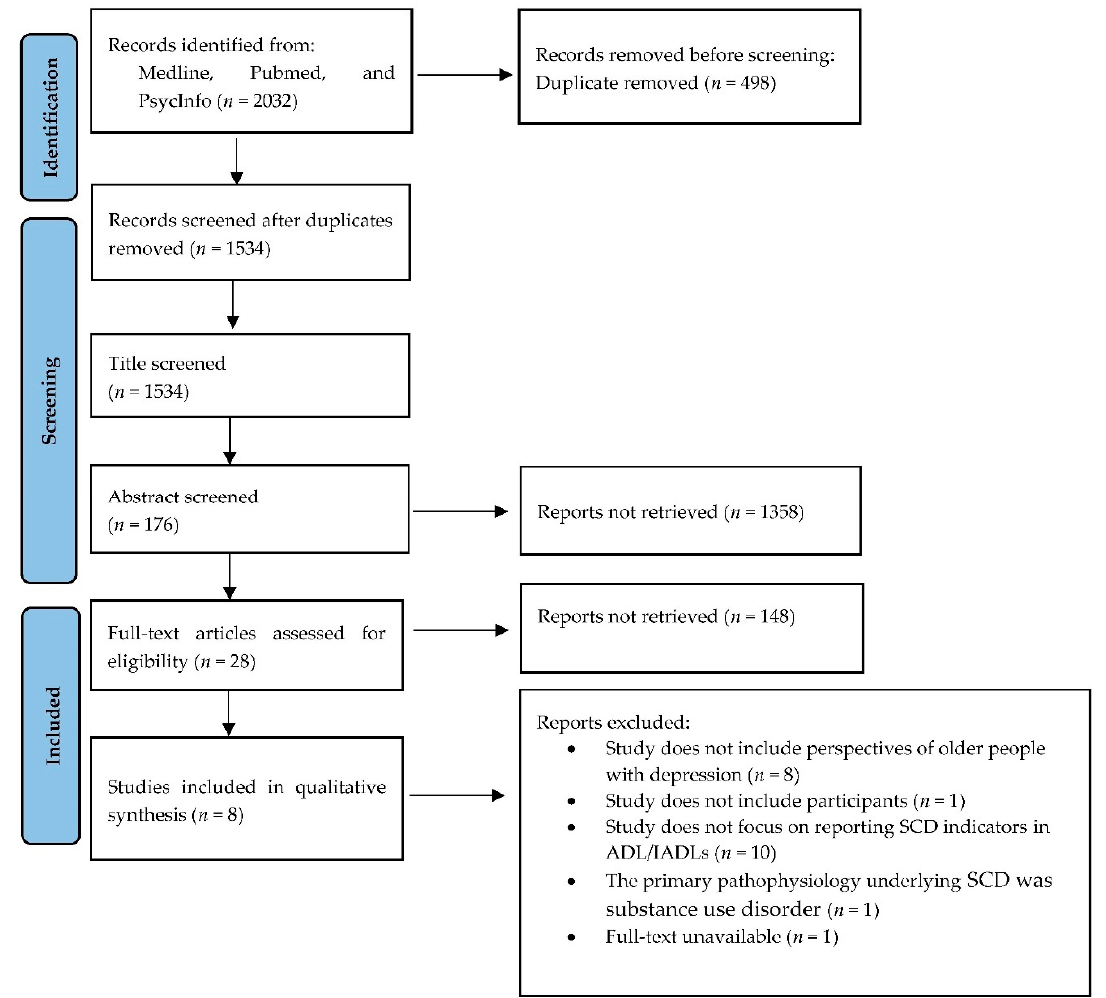
Figure 1. Flow diagram showing the numbers of publications identified and screened for eligibility during the scoping